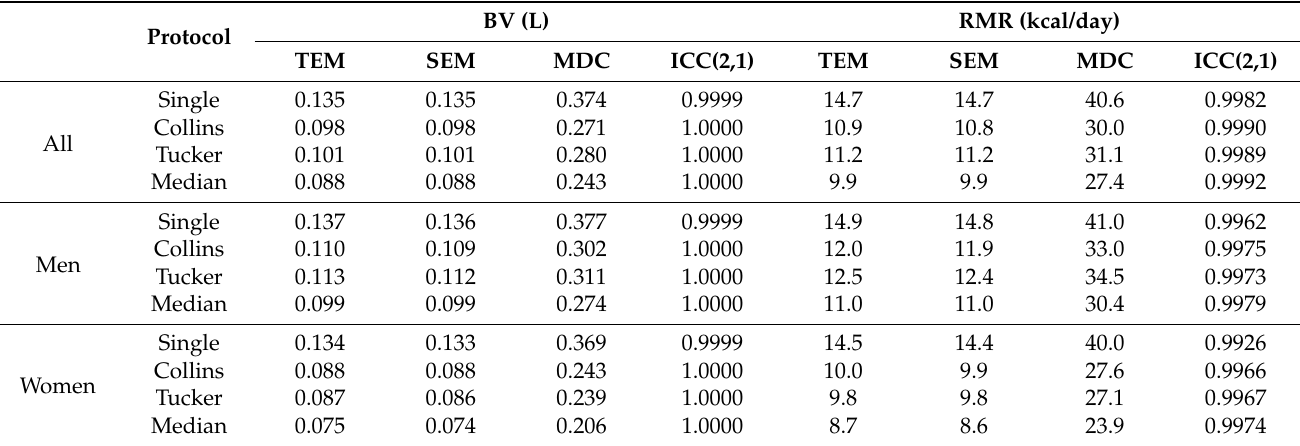
Table 5. Statistical parameters of the reliability of various protocols for BV measurements and RMR estimates provided by the BOD POD software relying on measured fat mass and fat-free mass